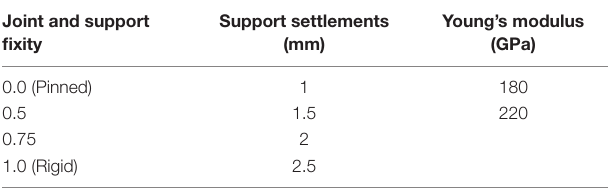
TaBle 3 | Variables and their values for generating